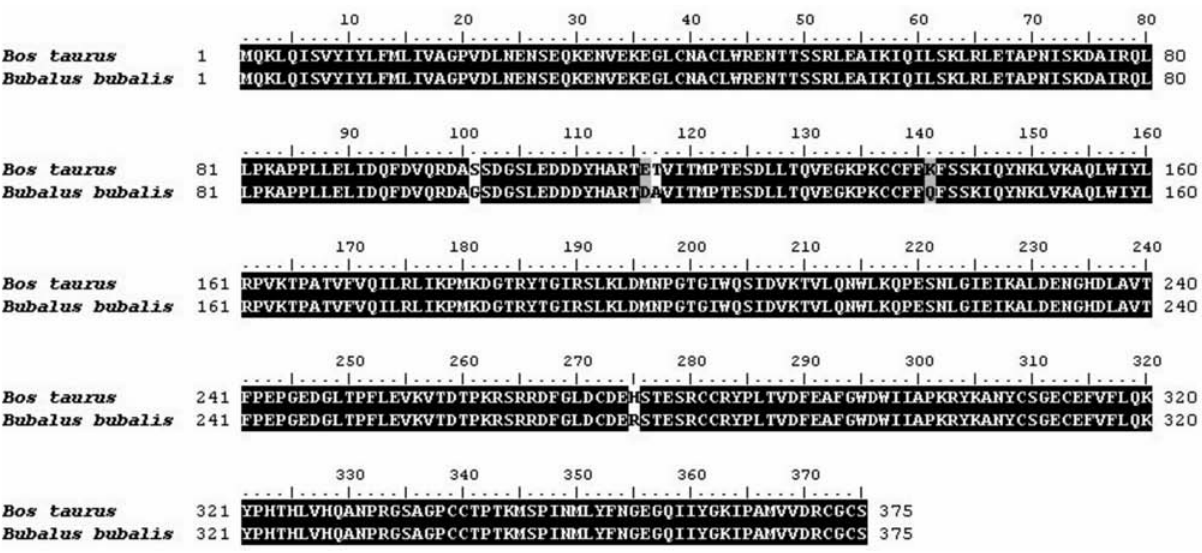
Figure 1 - Comparative alignment of the presumed myostatin amino acid sequence from non double-muscled Bos taurus (AF320998) and Bubalus bubalis . Shaded amino acids indicate matching sequence